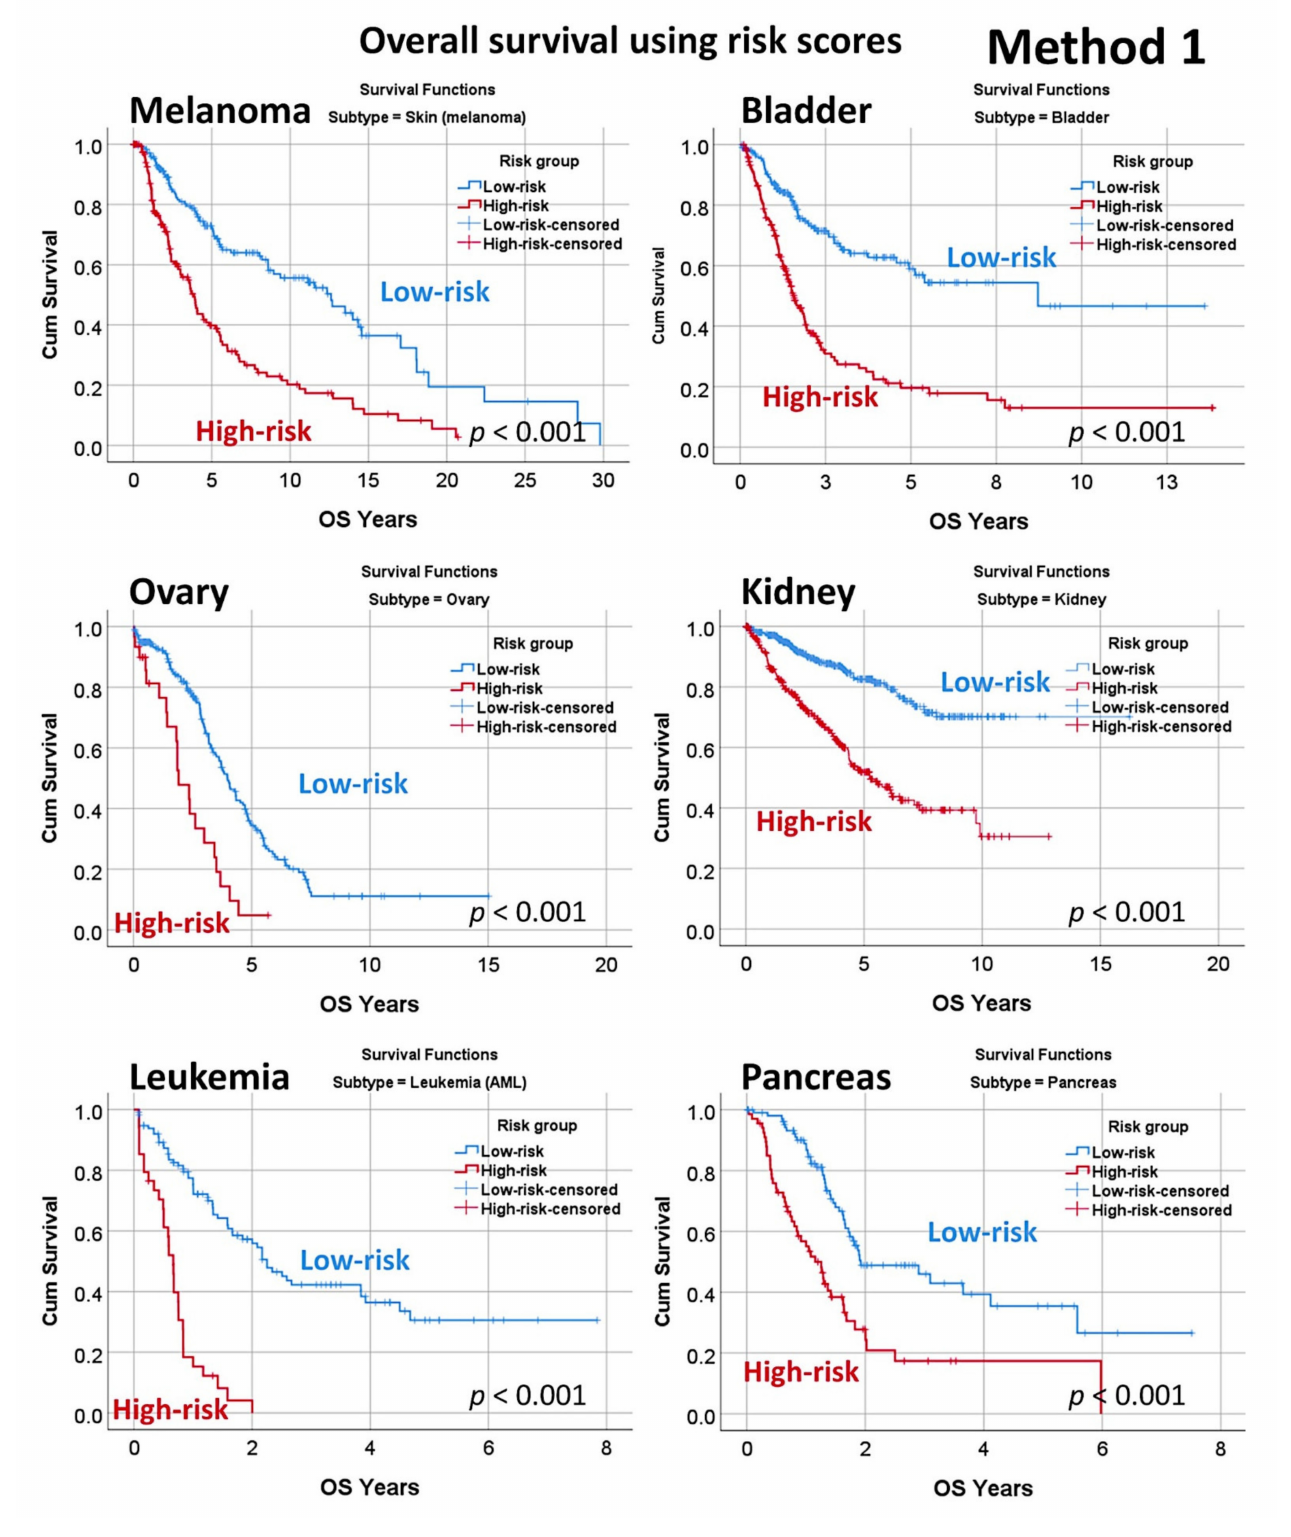
Figure 10. Overall survival in a pan cancer